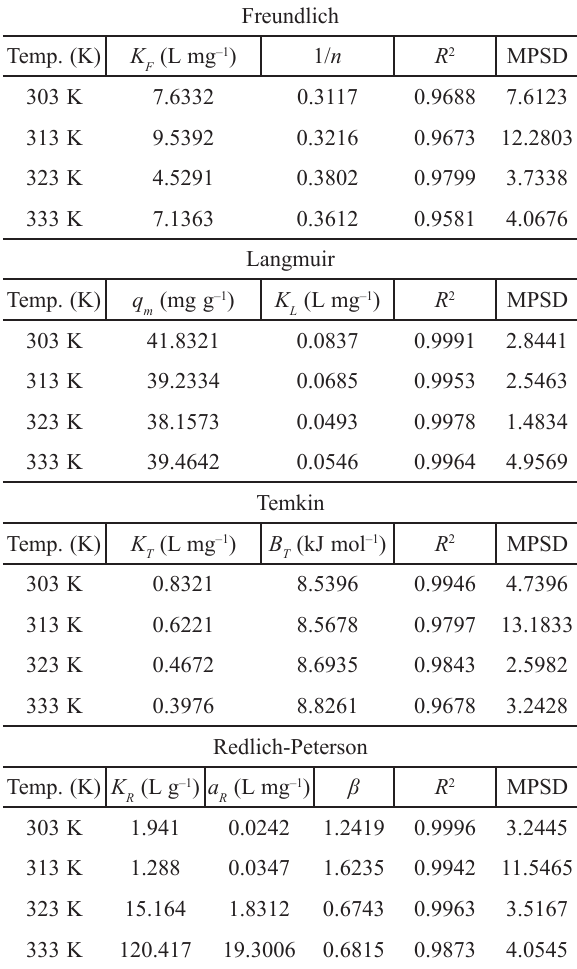
Table 3 – Isotherm modeling of experimental data for 2-CP-RSAC adsorption system Freundlich Temp. (K)